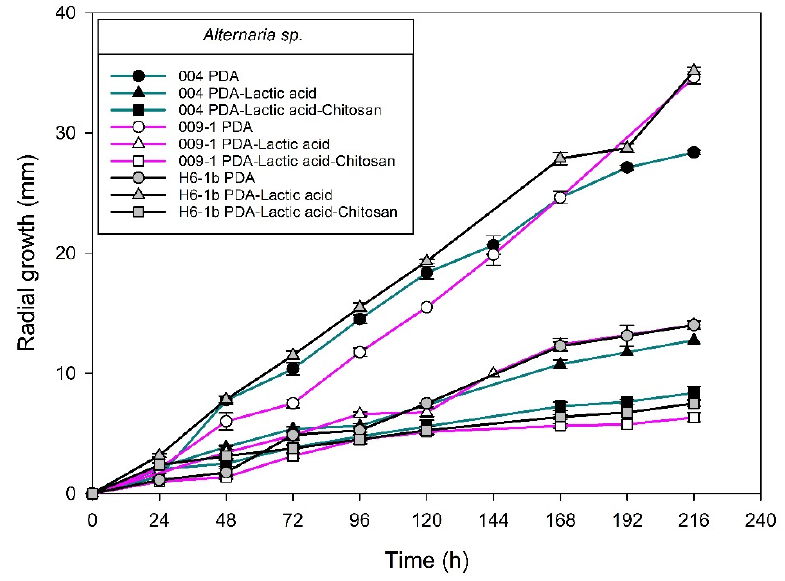
Figure 8. Alternaria sp. isolated from anthracnose of mango. Kinetics of radial growth (mm) in medium PDA, PDA-lactic acid (0.05 M), and PDA-lactic acid (0.05 M) with 1 g L − 1 chitosan at 25 ◦ C.